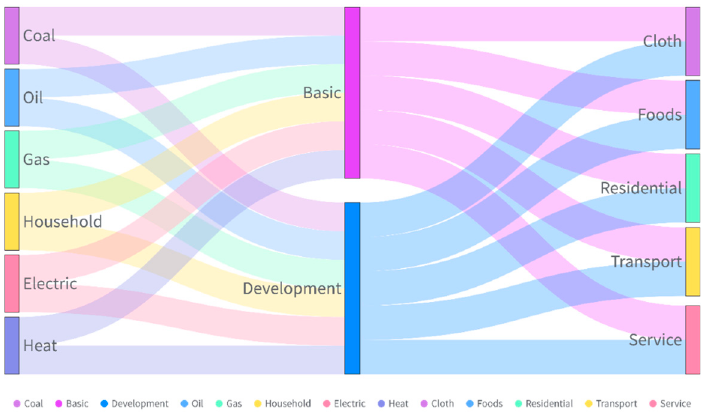
Figure 6. The main research subjects for HCEs.